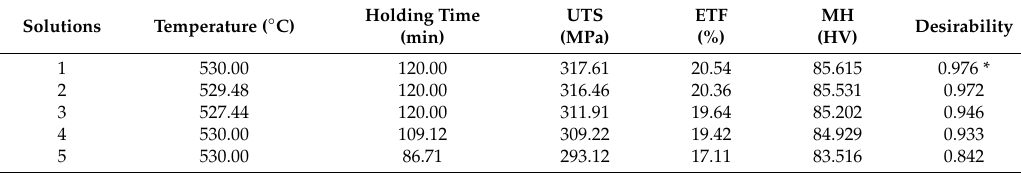
Table 6. Suggested solution for optimum responses.